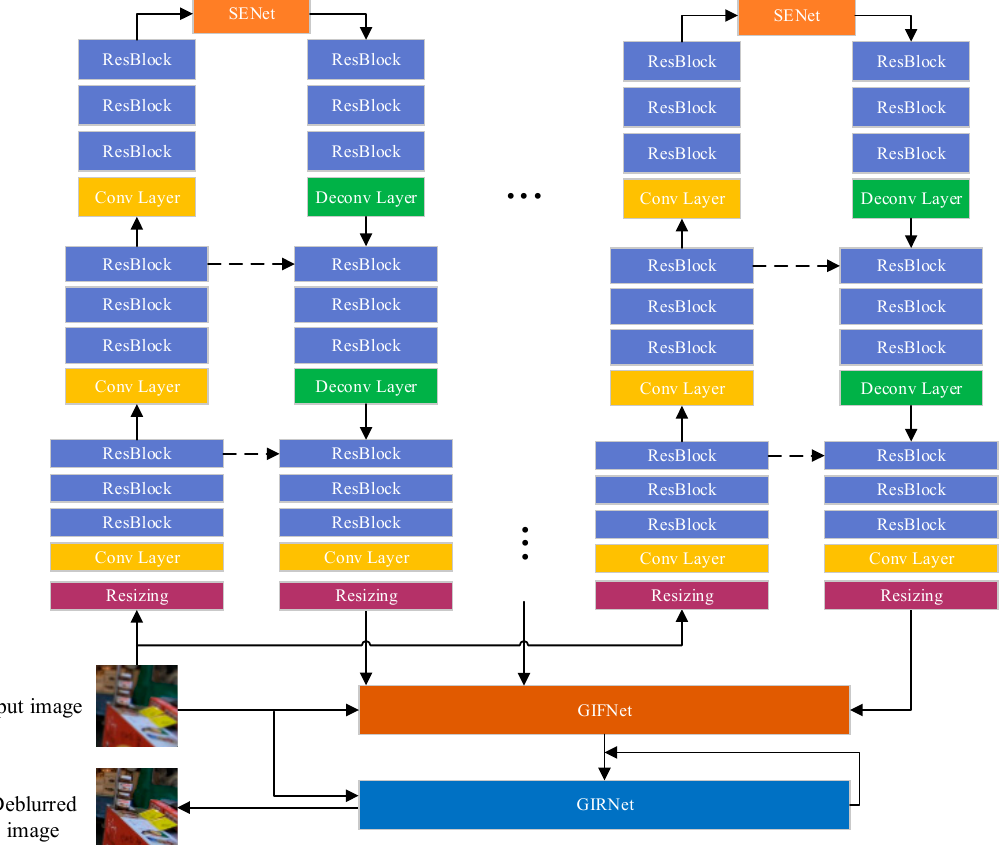
Figure 1. The flowchart of the proposed method. Each colored box is considered to be a feature block, and the arrows between blocks represent the information stream.